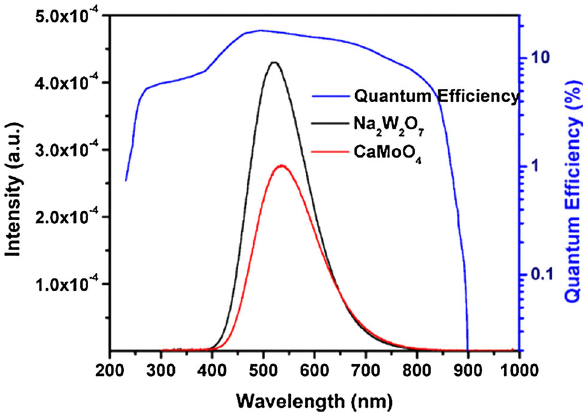
Fig. 9 Emission spectra of NWO and CMO at 10K along with QE spectrum of the